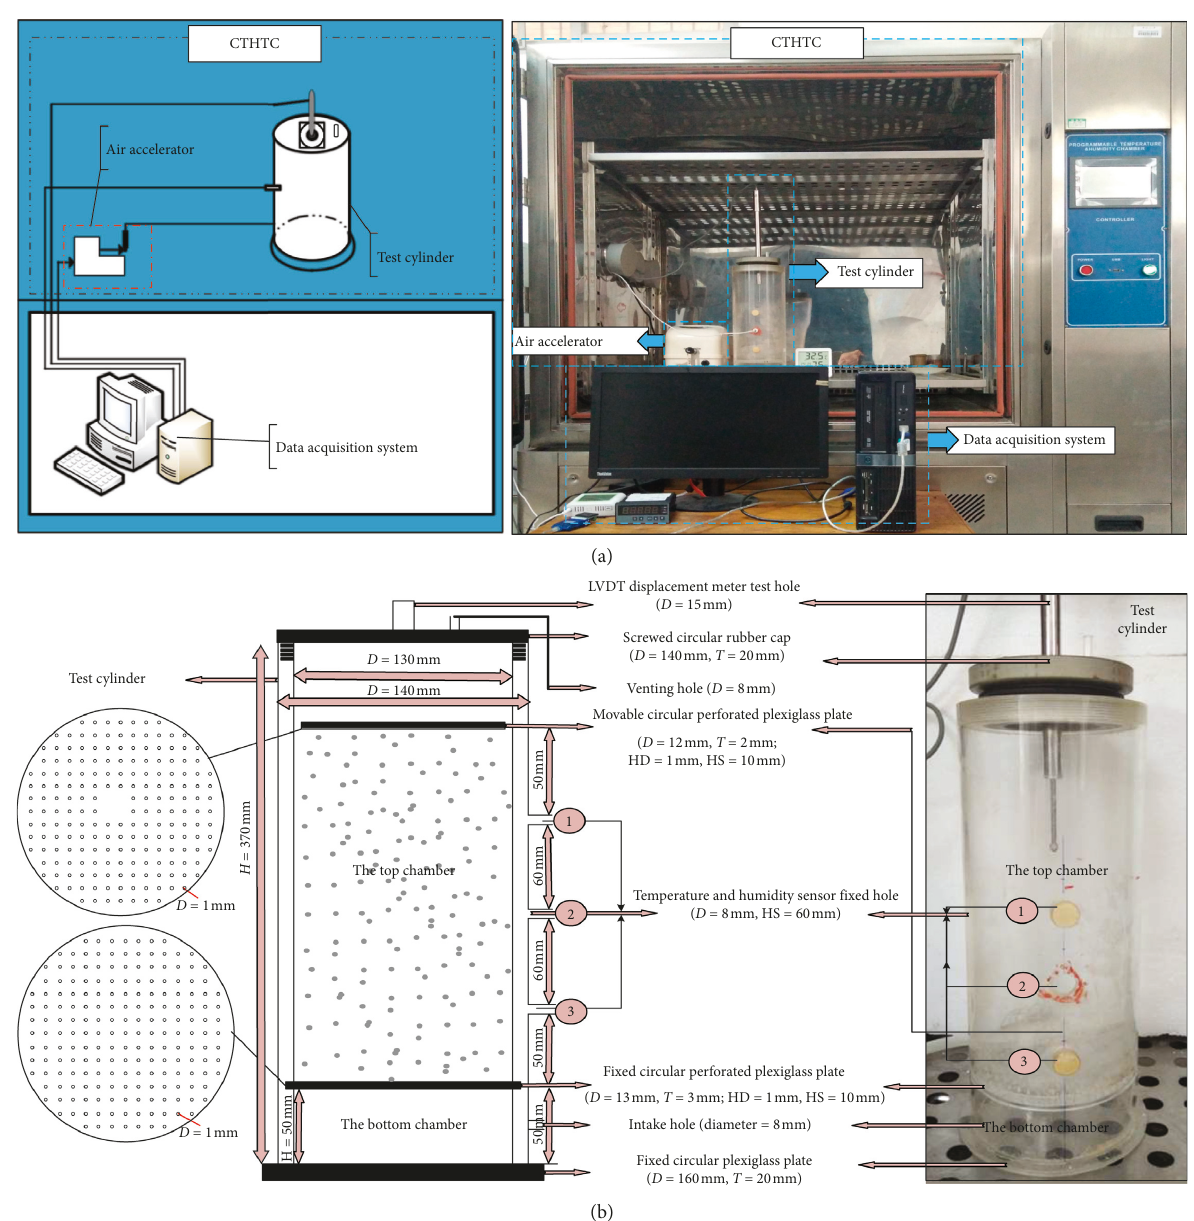
Figure 3: Sulfate saline soil displacement projection model device ( D � diameter; H � height; T � thick; HD � hole diameter; HS � hole space). (a) Device design and physical drawing. (b) Sodium sulfate saline soil test cylinder [19,